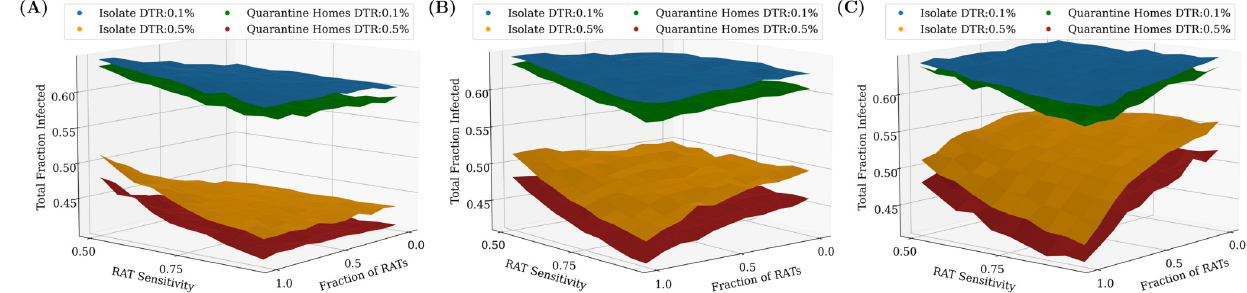
Fig 8. Effects of PCR test delays and quarantining homes. Testing is started when 20% of the population has recovered. (A) No PCR delay. Quarantining the home locations of the individuals in addition to isolating them at home is seen to have a small but not-insignificant benefit when there is no test delay. (B) 2 day PCR delay. When the PCR delay is increased to 2 days, the relative benefit of having PCR tests in the mixture is seen to disappear. (C) 5 day PCR delay. As the delay is further increased, the trend becomes clear: using even weak point-of-care RAT tests would be preferable to PCR tests with high delays. Additionally, when there are PCR delays, the benefit of increased testing is greatly diminished. In this case, however, the improvement that comes from quarantining of homes is much more significant at higher testing rates. As before, the plots were obtained by averaging over 100 simulation runs of 200 days each.